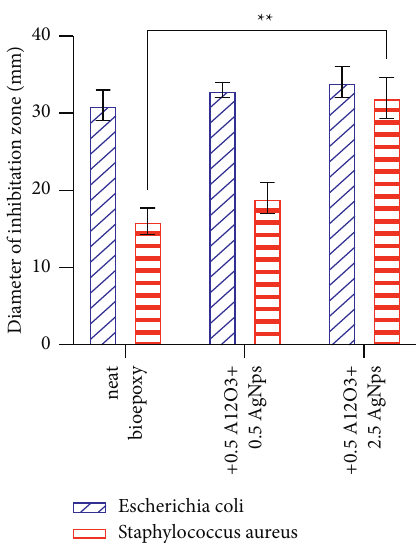
Figure 5: Zone of inhabitation of pristine bioepoxy and bioepoxy reinforced by various weight fractions of Al S. aureus .